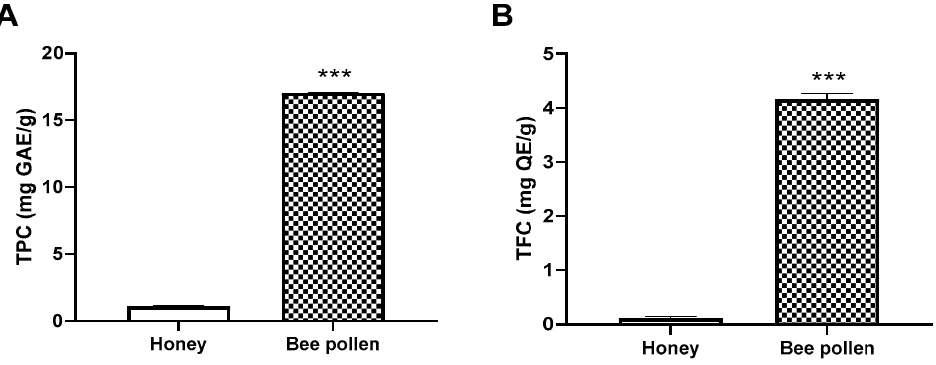
Figure 1. Total phenolic ( A ) and flavonoid ( B ) content of honey and bee pollen. *** p < 0.001 vs. Honey samples.